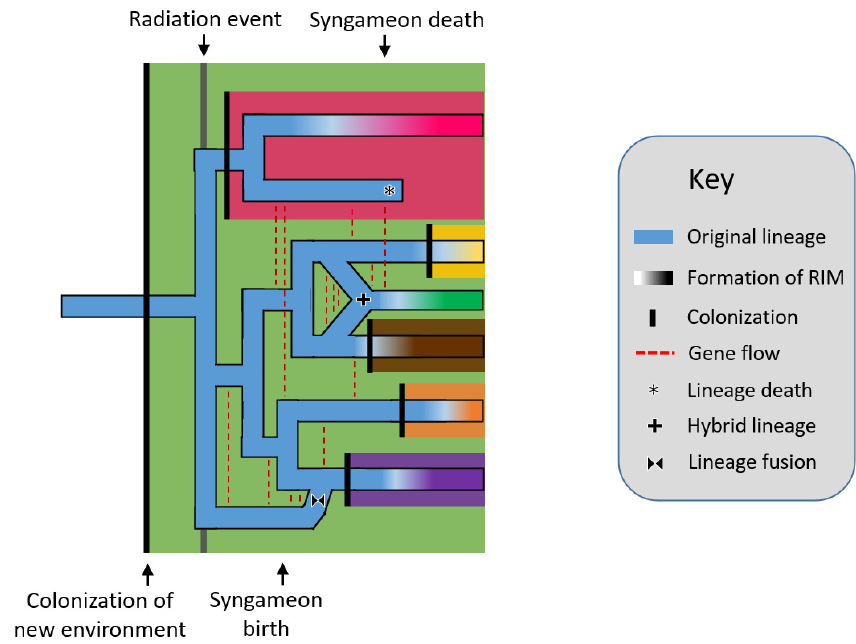
Figure 1. Rapid radiation hypothesis showing a lineage (blue horizontal line) colonizing a new environment (black vertical line), which eventually triggers a rapid radiation event. Speciation is followed by gene flow events (red dashed lines) which form a syngameon. The eventual collapse of the syngameon occurs when reproductive isolating barriers form among species, usually after the colonization of new environments, leaving two or no species with interspecific gene flow. Several potential outcomes are shown including hybrid speciation (plus symbol), extinction (asterisk), and fusion (bowtie symbol). RIM = reproductive isolation mechanism.